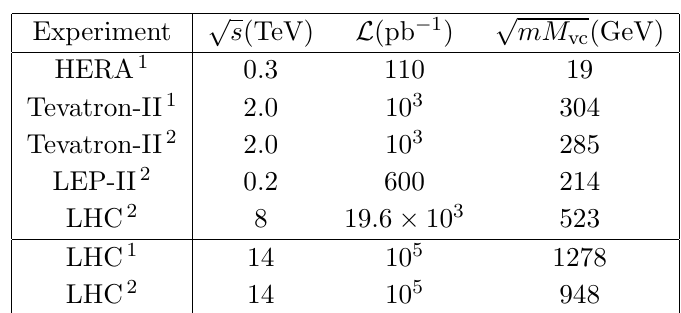
Table 1 . Summary table for the phenomenology of vectors and disformal scalars coupled to the energy-momentum tensor at colliders. Monojet and single photon analyses are labeled by the upper indices 1 ; 2, respectively. Present bounds and prospects for the LHC [65{69] are compared with constraints from LEP [40, 64], HERA and Tevatron [65, 66]. energy associated with the total process; L denotes the total integrated luminosity; constraint at the 95 % con(cid:12)dence level by assuming a very light vector (in the limit m ! 0). The e(cid:11)ective coupling is not valid for energy scales (cid:3) 2 & 8 (cid:25)